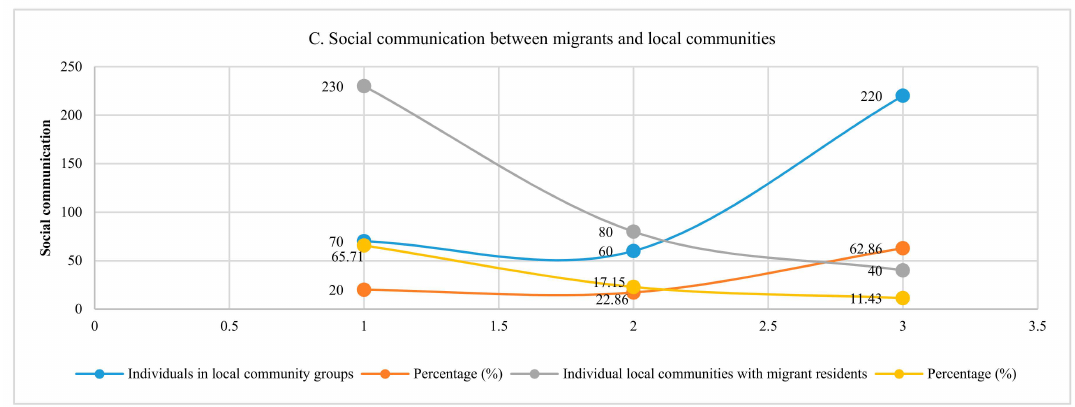
Figure 15. ( A – C ) Social interactions between local communities and migrant populations. Source: Primary